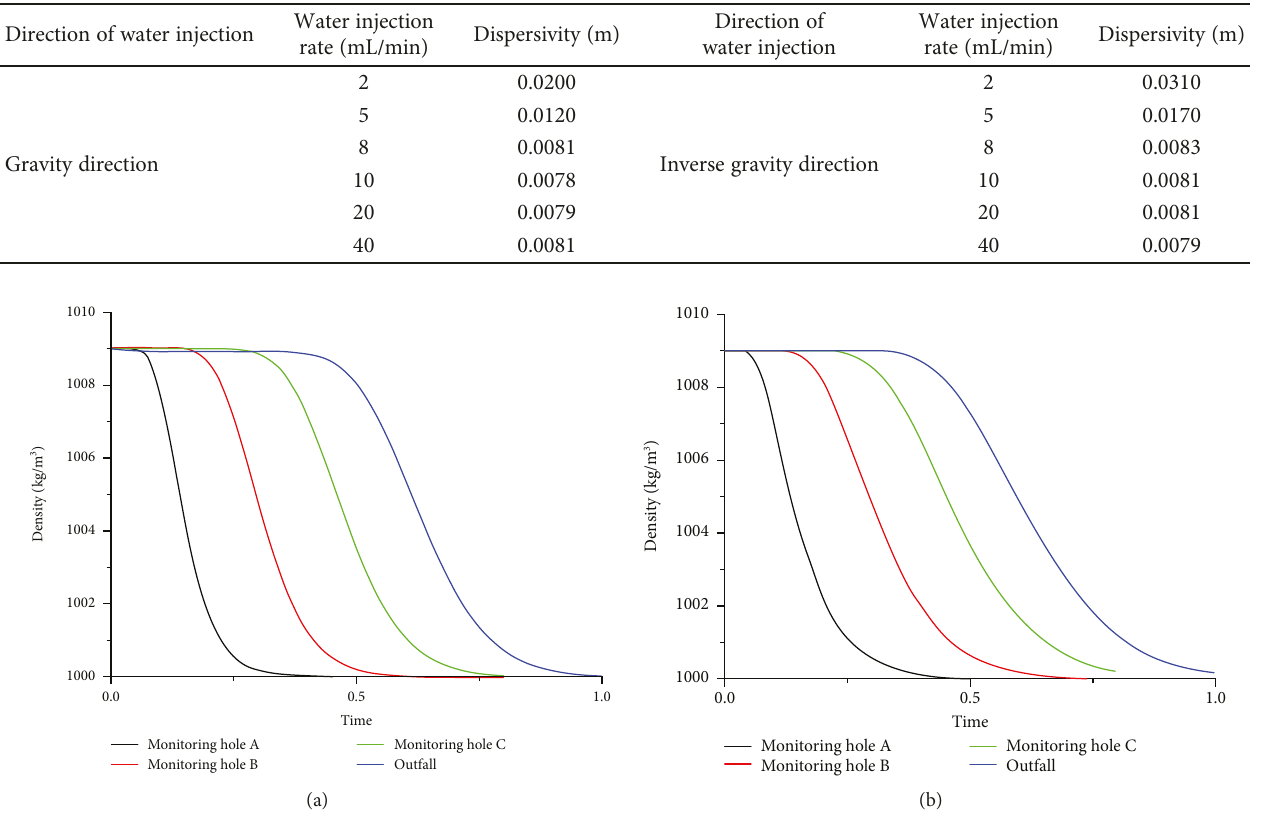
Figure 9: Comparison of density in di ff erent injection directions when the water injection rate is 2mL/min: (a) gravity direction and (b) reverse gravity direction.